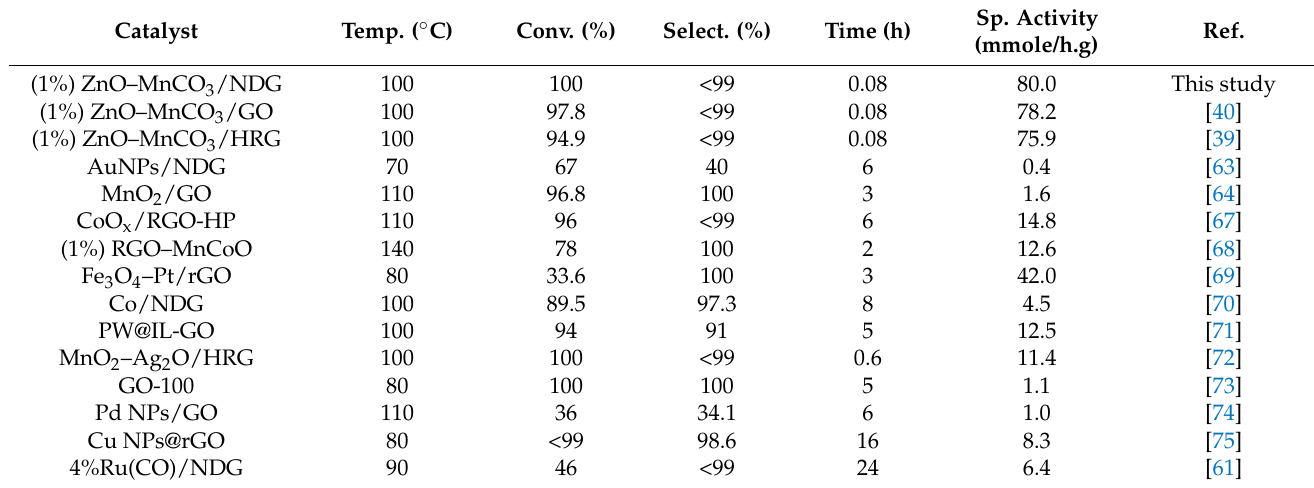
Table 3. Comparison of the (1%) ZnO–MnCO 3 /(1%-NDG) catalyst for aerial oxidation of BOH with already published catalytic systems containing